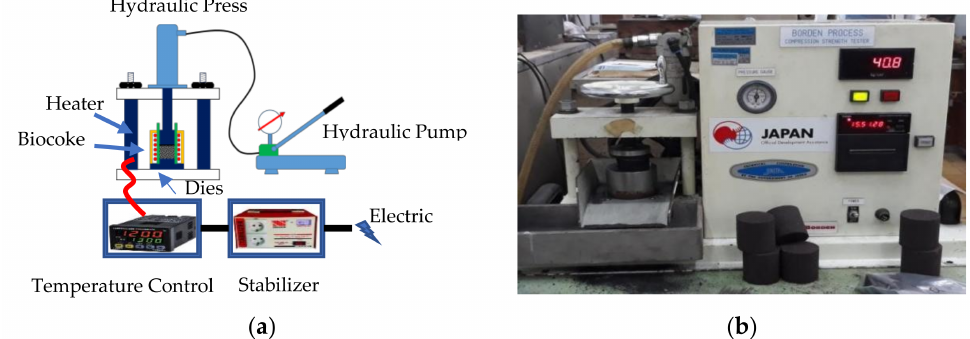
Figure 2. Coal blending process: ( a ) hot briquette process scheme; ( b ) compression strength